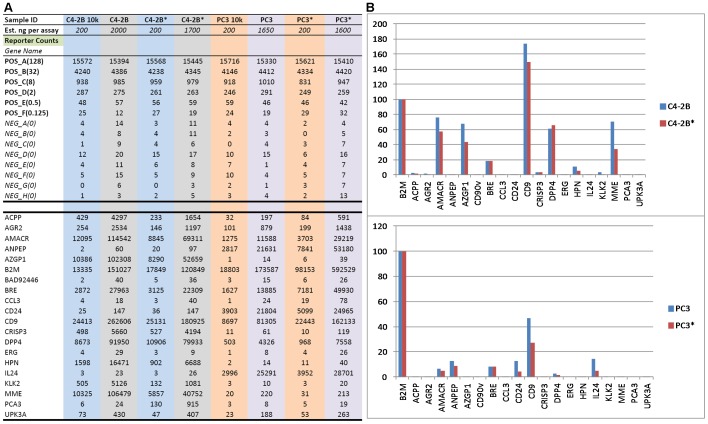
RNA amplification. A.Shown is Excel format of nCounter data from unamplified vs. amplified (marked by *) RNA of C4-2B and PC3 cells. POS and NEG are control probesets. B. Signal counts obtained from unamplified vs. amplified (marked by *) are compared in histogram display. Gene count for B2M is set at 100 and all other gene counts are compared to that of B2M from the same sample. Note genes with absent expression were not amplified.